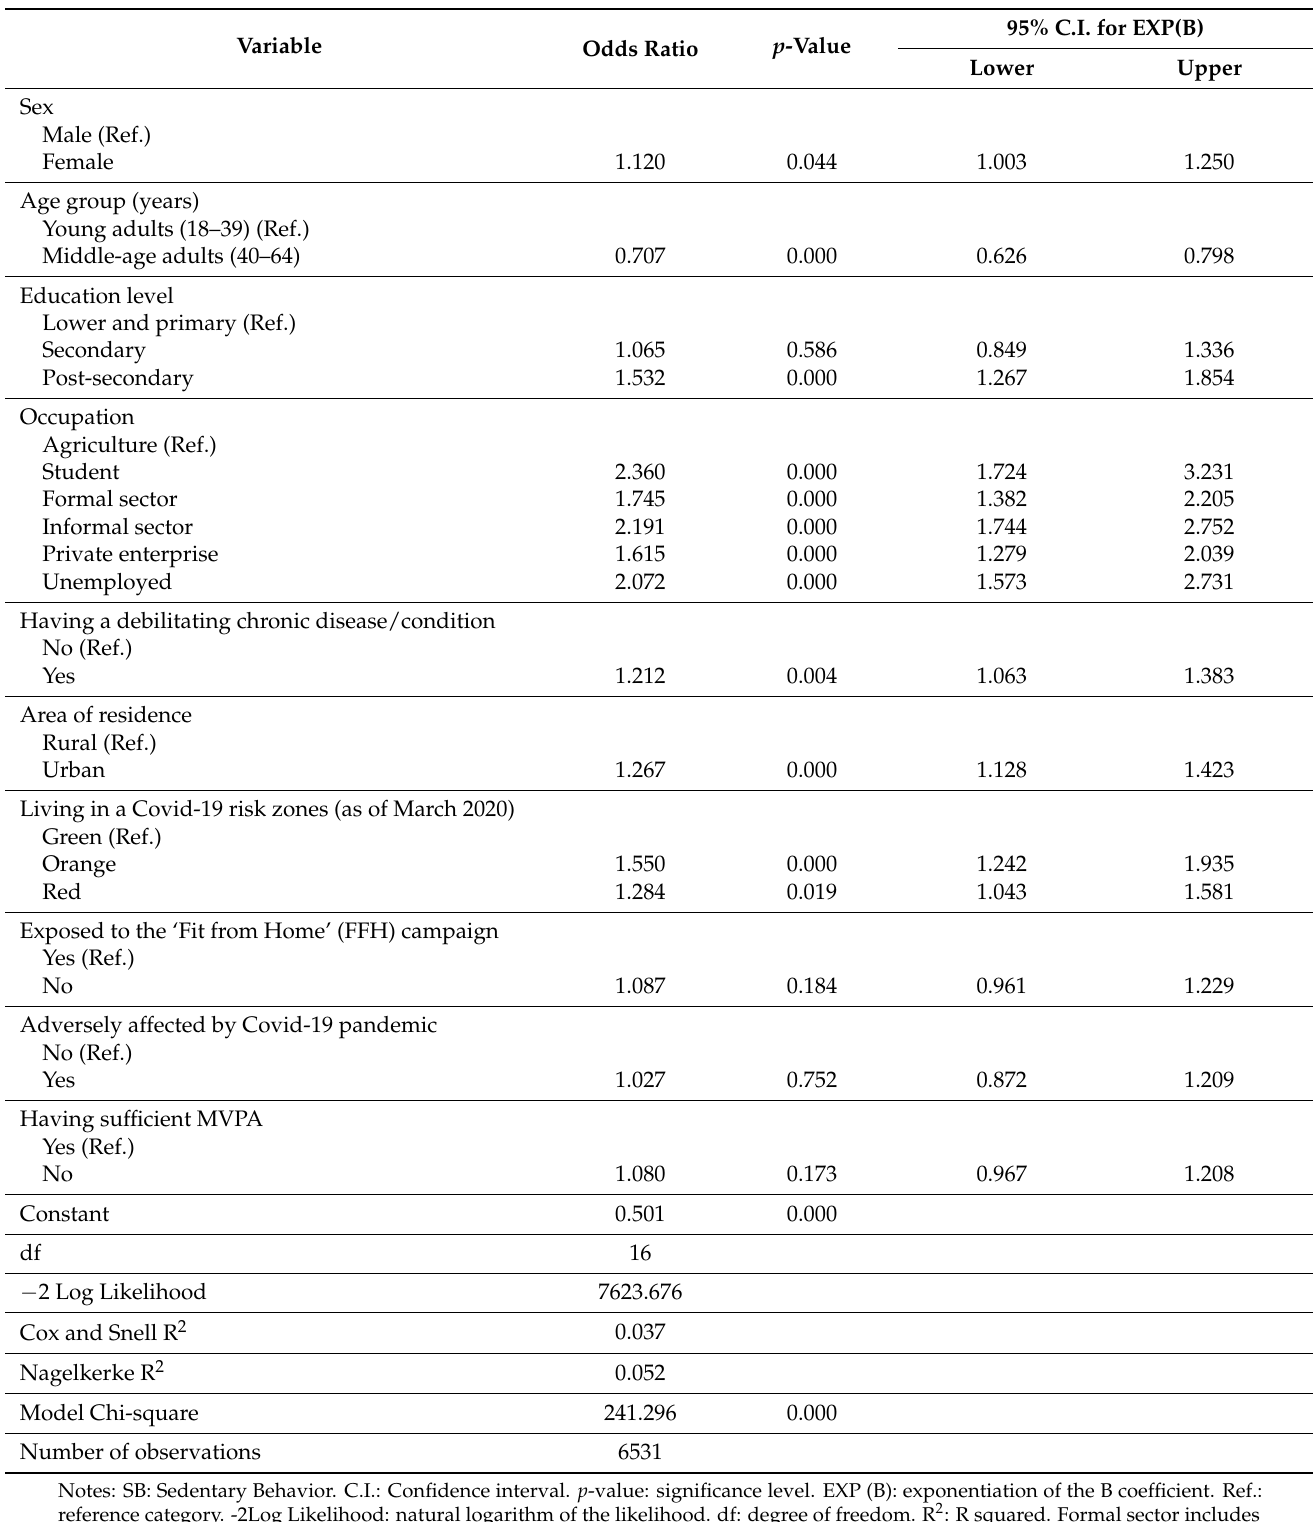
Table 3. Correlates of SB during Covid-19